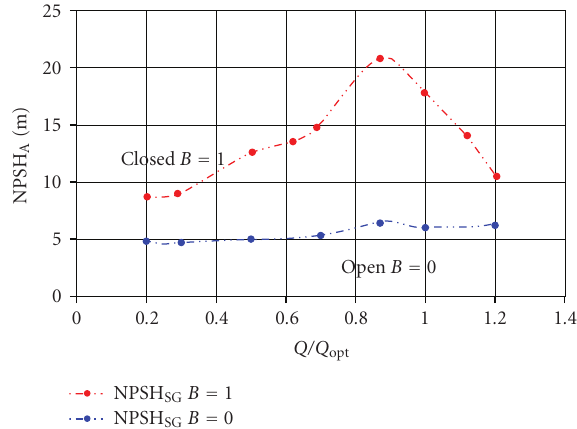
Figure 14: Subjective cavitation NPSH SG —curves with ( B = 0) and without ( B = 1) cavitation bores n = 725